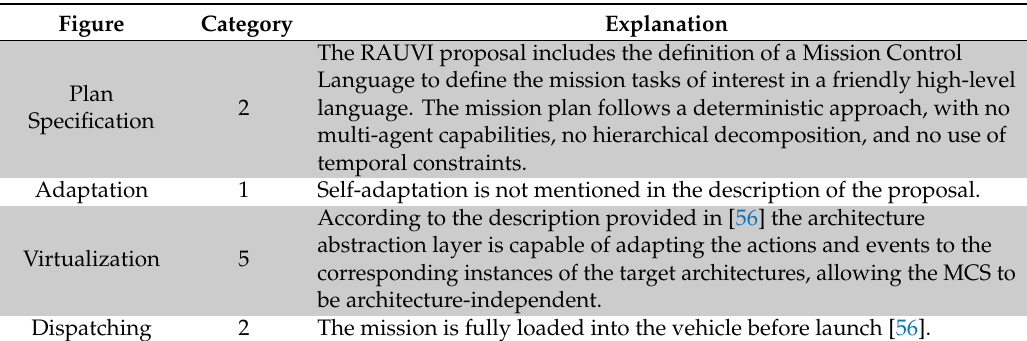
Figure Category Explanation The RAUVI proposal includes the definition of a Mission Control Language to define the mission tasks of interest in a friendly high-level Plan 2 language. The mission plan follows a deterministic approach, with no Specification multi-agent capabilities, no hierarchical decomposition, and no use of temporal constraints. Adaptation 1 Self-adaptation is not mentioned in the description of the proposal. According to the description provided in [56] the architecture abstraction layer is capable of adapting the actions and events to the Virtualization 5 corresponding instances of the target architectures, allowing the MCS to be architecture-independent. Dispatching 2 The mission is fully loaded into the vehicle before launch